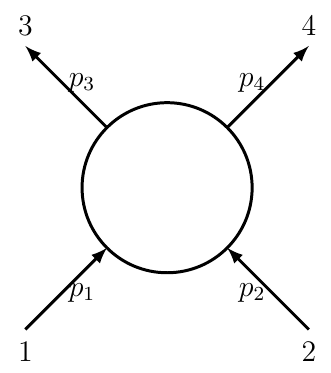
Figure 6 . 2 → 2 scattering of